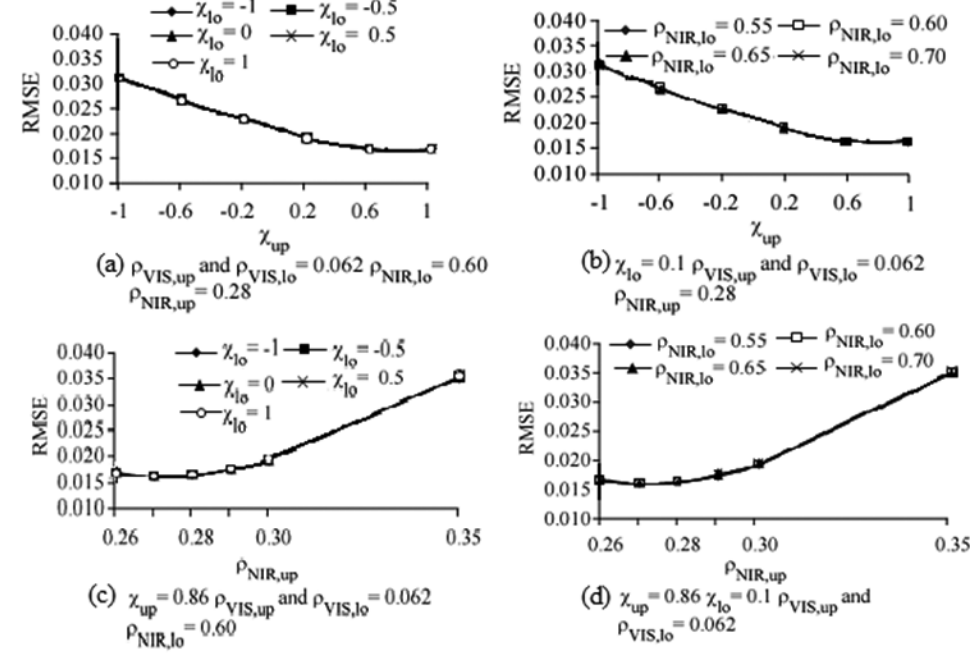
Fig. 3 – Root Mean Square Error (RMSE) as a function of a) χ up and χ lo , b) χ up and ρ NIR , lo , c) ρ NIR , up and χ lo , and d) ρ NIR , up and ρ NIR , lo , for the Cuieiras Biological Reserve